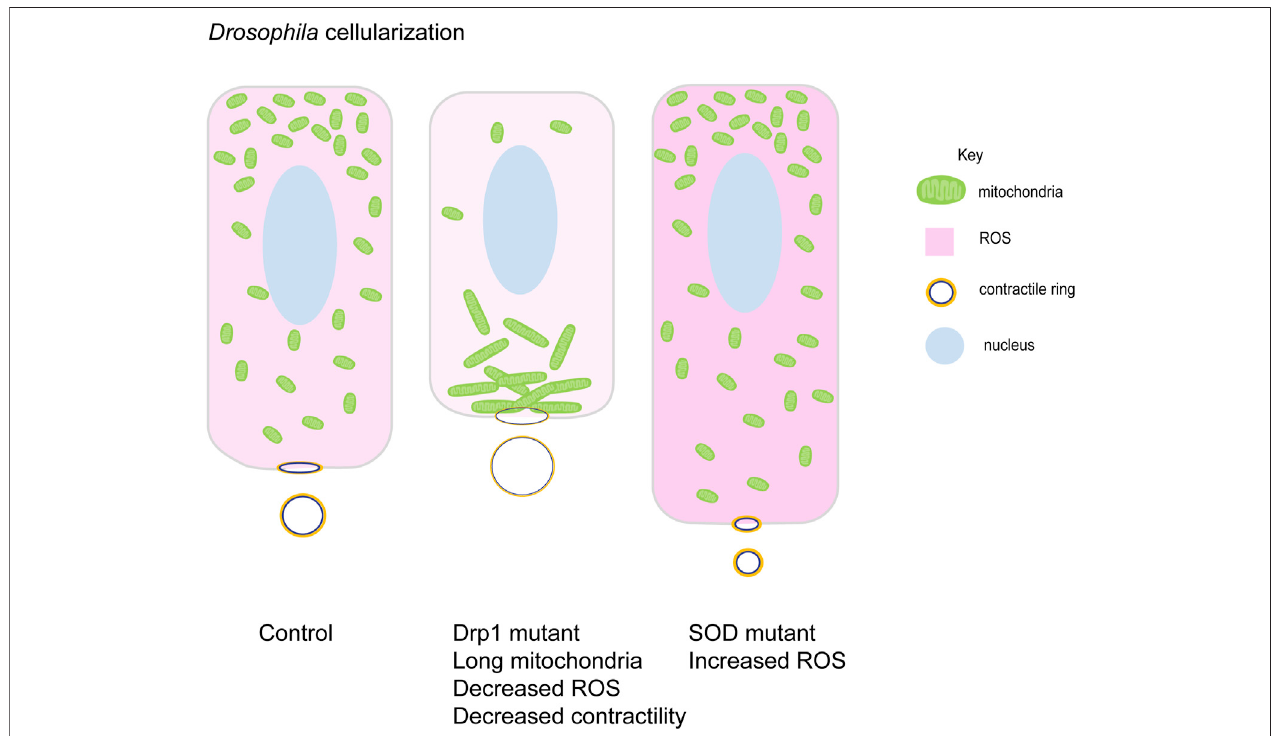
FIGURE 5 | Mitochondrial morphology function in cellularization in Drosophila embryogenesis. Small round mitochondria migrate apically during cellularization in Drosophila embryos. Schematic represents the terminal timepoints of cellularization in control, Drp1 mutant and SOD mutant embryos. Light to dark pink shades represent increasing levels of ROS in these cells. Control embryos have apically migrated small mitochondria (green). Myosin II (yellow) is localized at basal contractile rings. Clustered mitochondria (green) in Drp1 mutant embryos accumulate basally and fail to migrate apically. Lowered ROS levels (light pink), lead to decreased Myosin II (yellow) and contractility at the contractile rings. These cells are shorter than controls with large contractile rings. SOD mutant embryos have high ROS levels (darkpink)andsmallmitochondria(green)arepresentapically.ThesecellsshowincreasedMyosinII(yellow)levelswithincreasedcontractilityandsmallerrings.Theyare taller compared to controls (Chowdhary et al.,